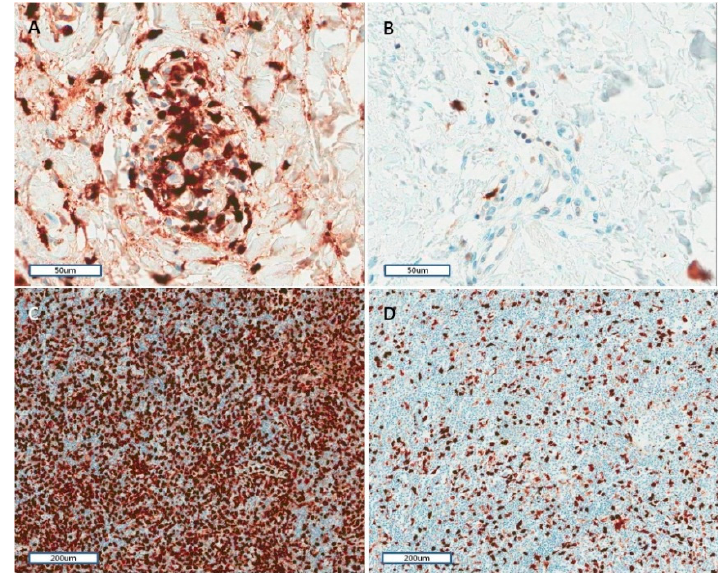
Figure 4. S100A8/A9 expression levels of inflammatory cells in skin and lymph node biopsy of patients with active adult-onset Still’s disease (original magnification, 200× ( A , B ), 100× ( C , D )). S100A8/A9 was recorded as the number of positive inflammatory cells divided by the number of total inflammatory cells, then expressed as a graded scale from 1 to 3: 1, 1%–33%, 2, 34%–66%, or 3, 67%–100%. The S100A8/A9 staining positive cells were graded from 1 to 3. Representative examples of frequent expression (grade 3, C ) and rare expression (grade 1, D ) are shown in the lymph node.